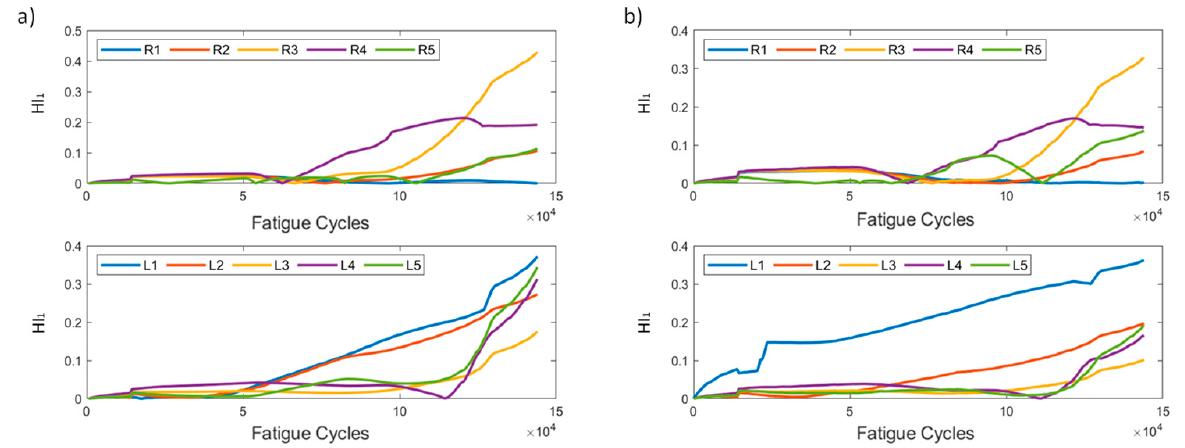
Figure 5. HI 1 progression through test cycles for the two pre-processing methods for specimen CA- ( b ) method 2. 2: ( a ) method 1, ( b ) method 2.